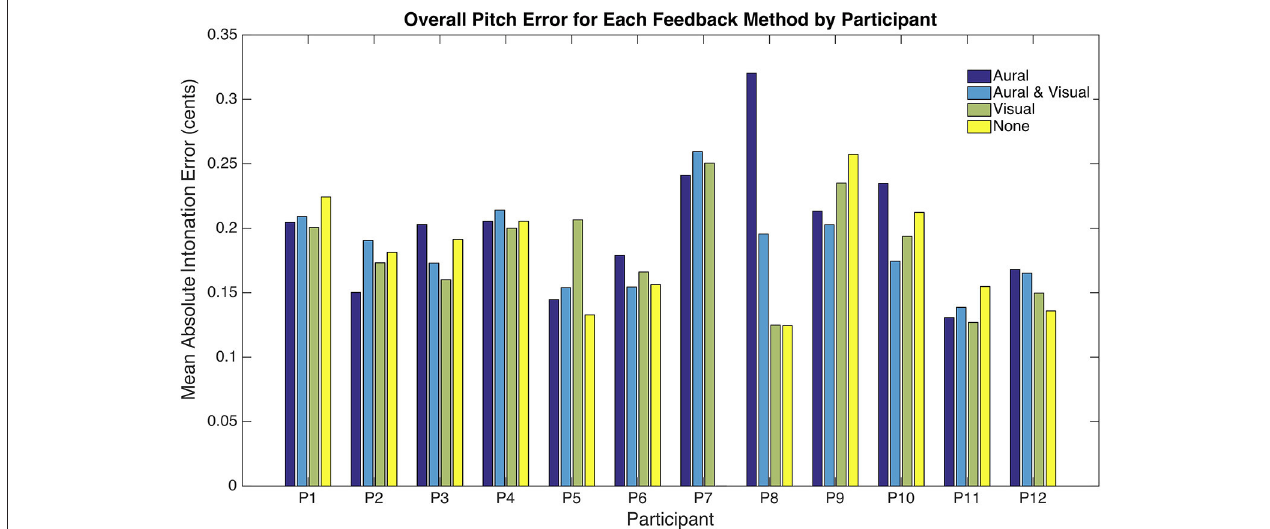
FIGURE 3 | Overall mean absolute intonation error per lesson for different feedback methods for each